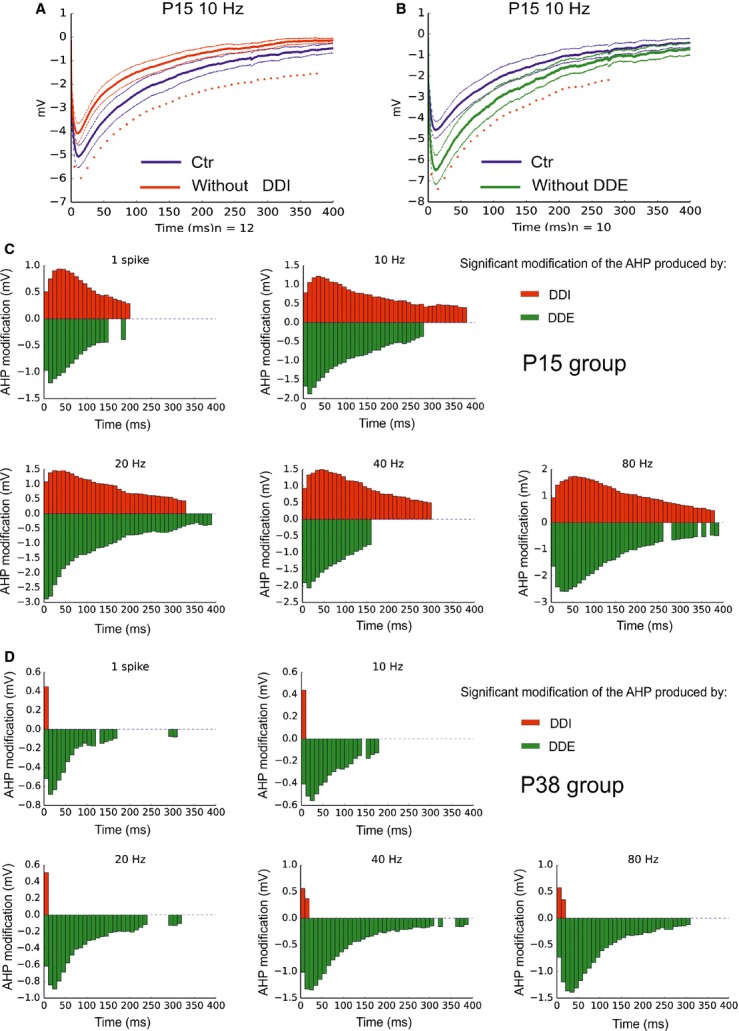
The impact of the recurrent DDE and DDI change with the animal age. (A) Average trace of the AHP in control condition (blue) and in the absence of recurrent DDI (red), that is, in the presence of GBZ. (B) Average trace of the AHP in control condition (blue) and in the absence of recurrent DDE (green), sees methods. Tin lines represent the SEM. Asterisks represent significant difference between the two curves (calculated on the average values of 10 msec bins). (C and D) Time course of AHP modification by the recurrent DDI (red) and DDE (green) in MC from P15 and P38 groups, respectively. Bars represent the difference between control and red curve (red) or control and blue curve (blue) for times bins that reach significance.